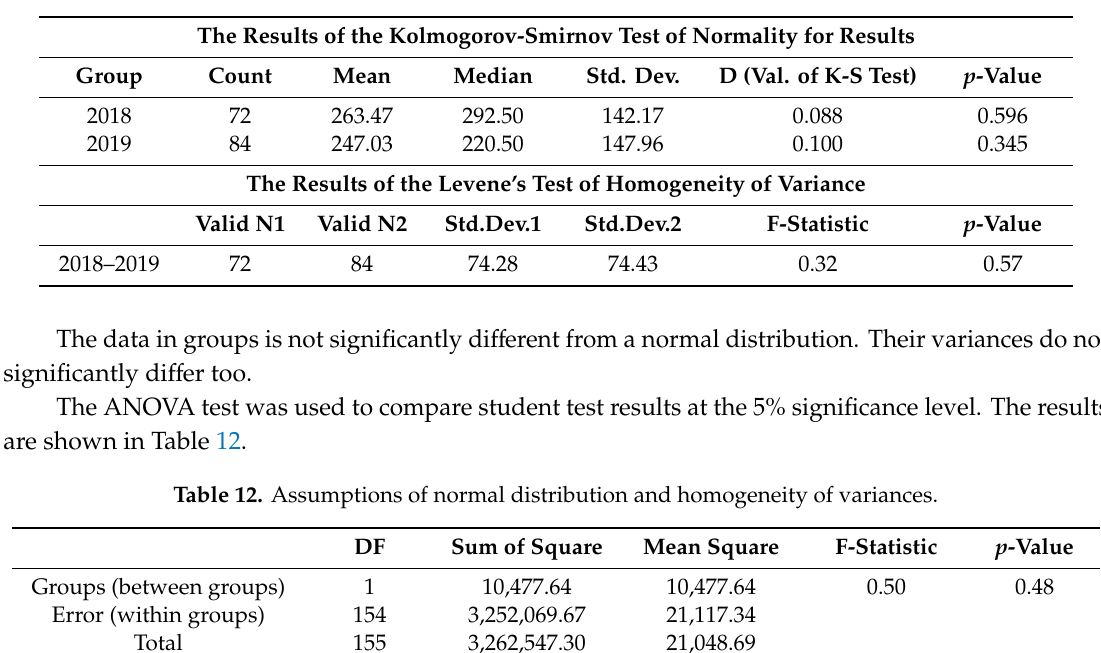
Table 11. Assumptions of normal distribution and homogeneity of variances.